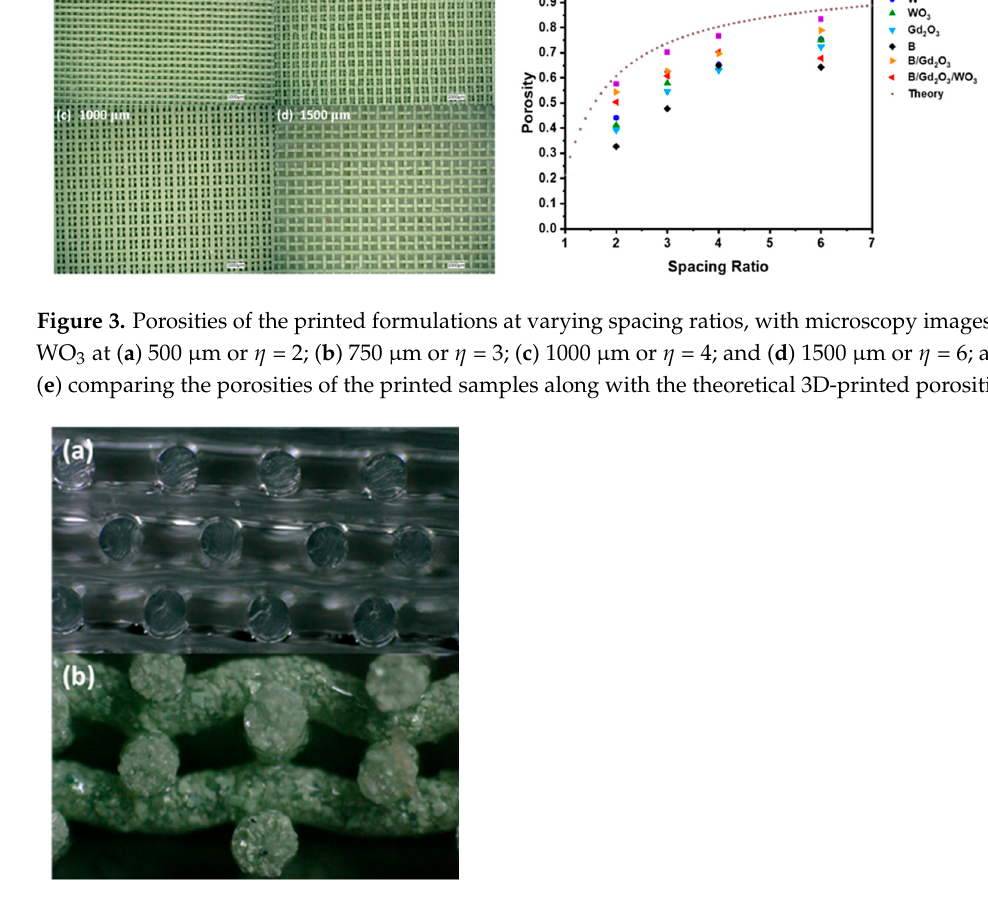
Figure 3. Porosities of the printed formulations at varying spacing ratios, with microscopy images of WO 3 at ( a ) 500 µm or η = 2; ( b ) 750 µm or η = 3; ( c ) 1000 µm or η = 4; and ( d ) 1500 µm or η = 6; and ( e ) comparing the porosities of the printed samples along with the theoretical 3D-printed porosities.